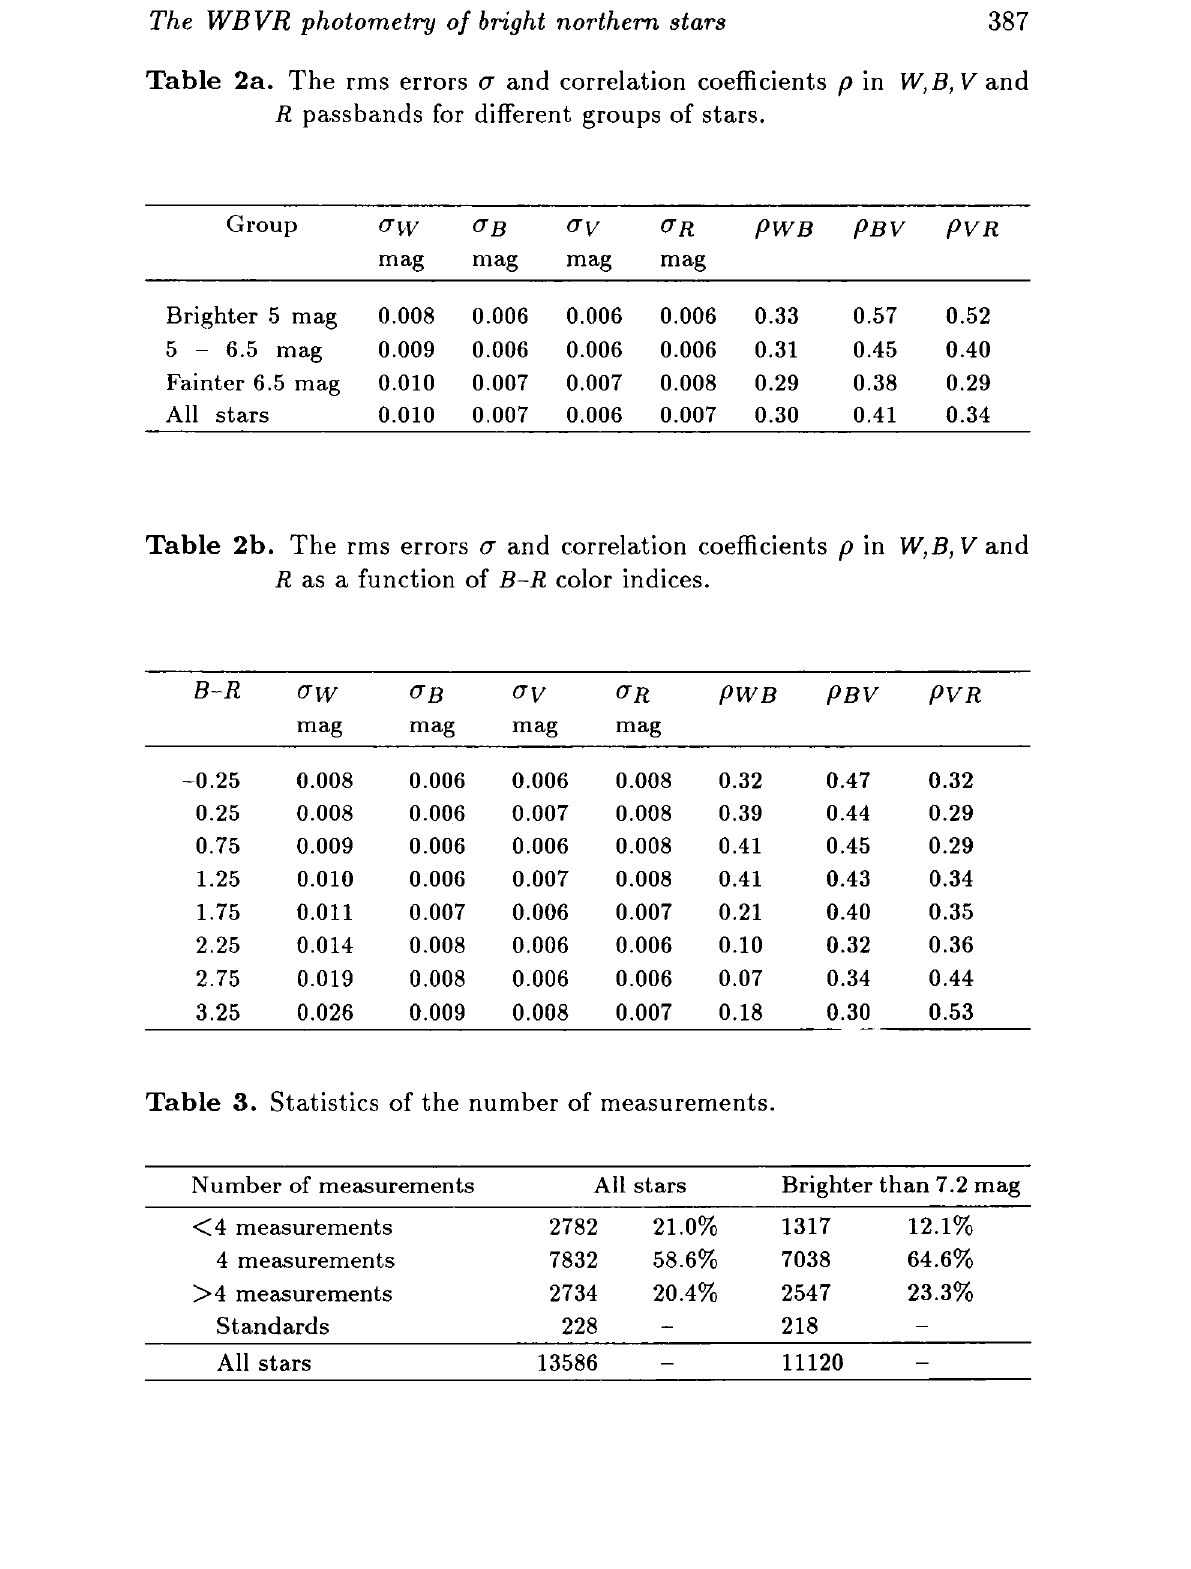
Table 3. Statistics of the number of